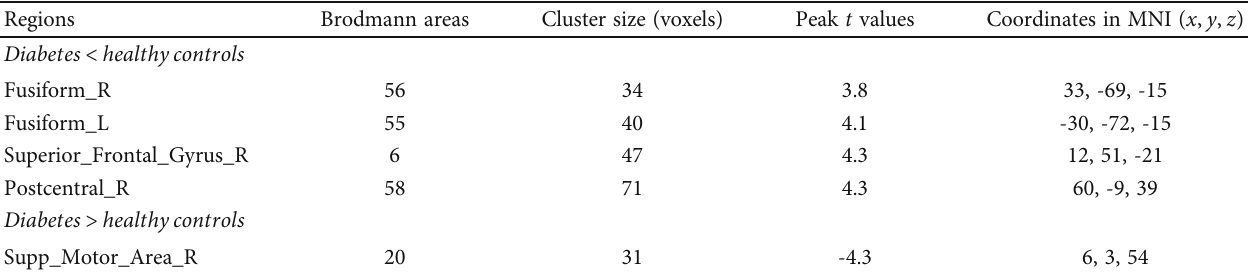
Figure 1: Group di ff erences in global FCS between patients with type 2 diabetes and healthy controls after correction for GMV ( P < 0 : 001 , uncorrected). HC: healthy controls; L: left; R: right; T2DM: type 2 diabetes Table 2: Brain regions with signi fi cant group di ff erences in FCS.